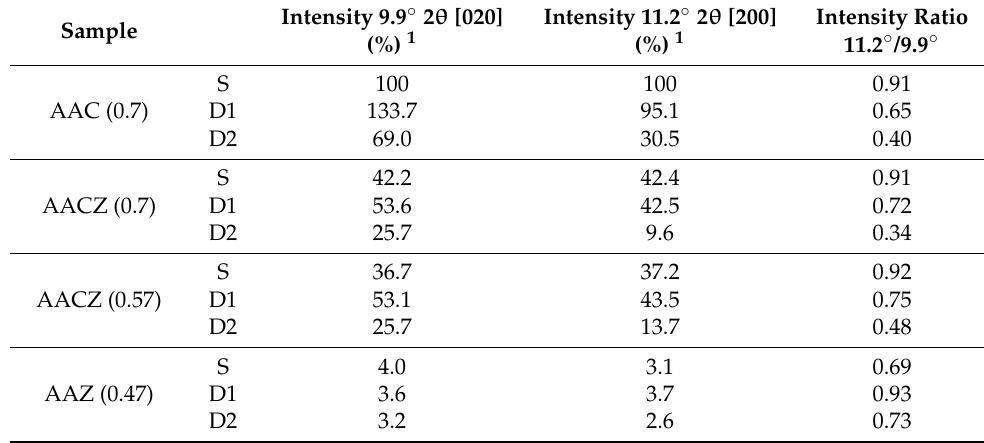
Figure 3. XRD pattern ( a ) and DRIFT spectra ( b ) of AAC (0.7), AACZ (0.7), AACZ (0.57) and AAZ (0.47) samples. 1 Clinoptilolite (PDF 83-1261); 2 quartz (PDF 65-0466); 3 anorthite (PDF 71-0748); 4 akermanite-gehlenite (PDF 79-2423). Table 2. Intensities at 2 θ of 9.9°and 11.2° and the intensity ratio of all samples.